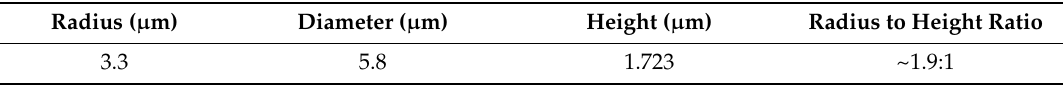
Table 2. Geometrical information of the fabricated microscale silicon solid immersion lens ( µ